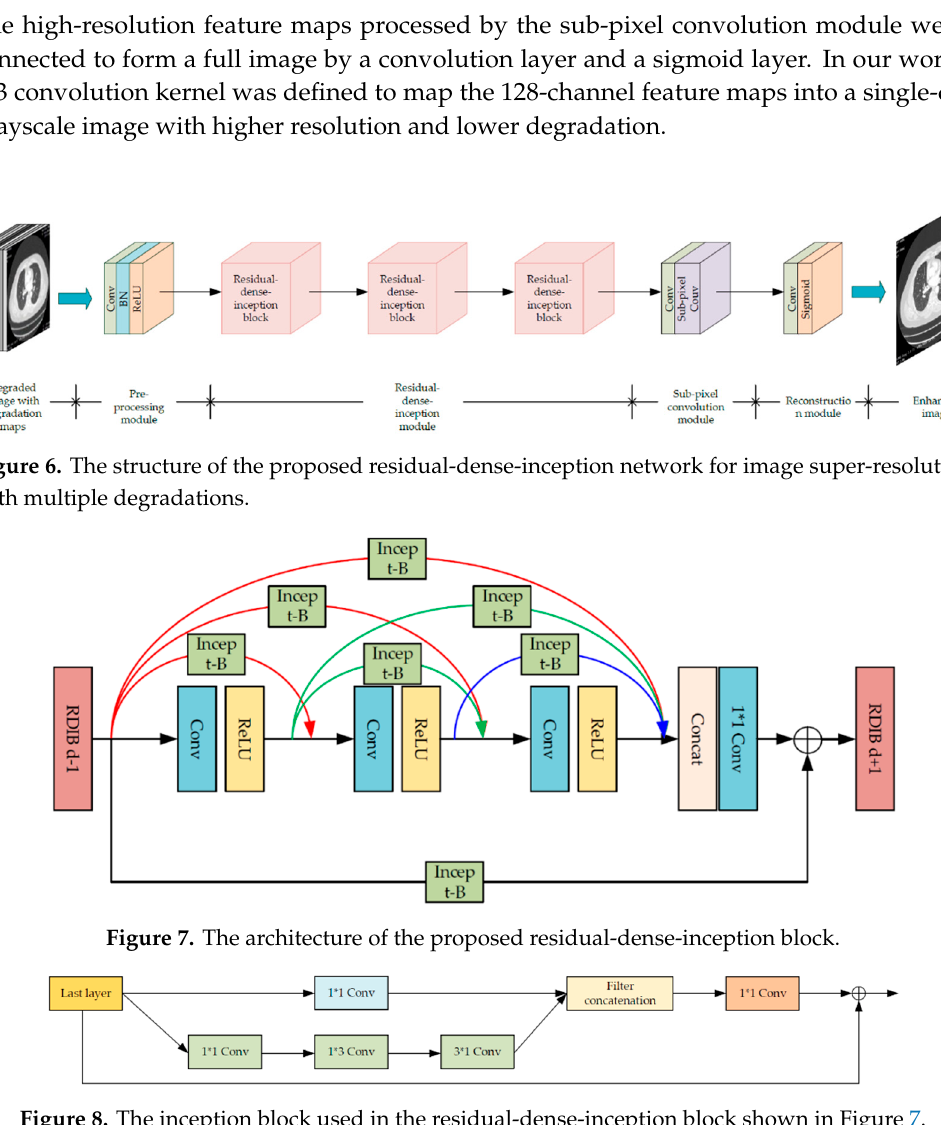
Figure 8. The inception block used in the residual-dense-inception block shown in Figure 7.